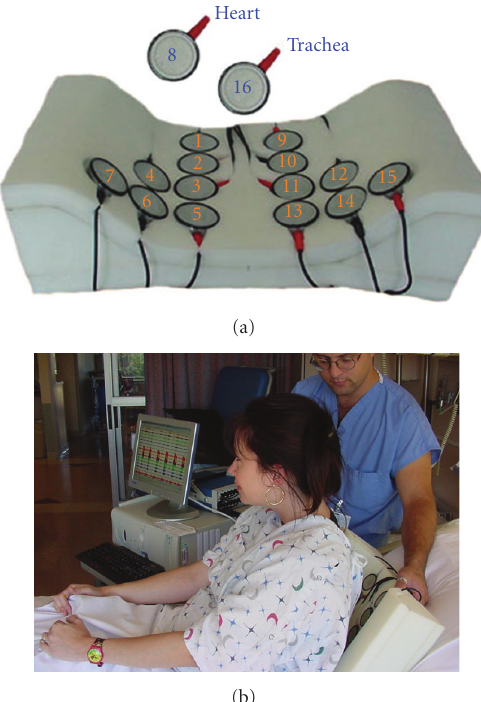
Figure 1: The multichannel lung sound analyzer: SteThoGraph or STG. (a) The arrangement of the microphones in the back pad arrayed over the posterior chest and lateral bases. Twelve microphones are placed on the back; numbers 1 through 6 are on the right side, 9 through 14 are on the left. There is one on each lateral base: microphone numbers 7 and 15, respectively. One microphone is over the trachea: number 16. (b) The placement of the soft foam pad containing the